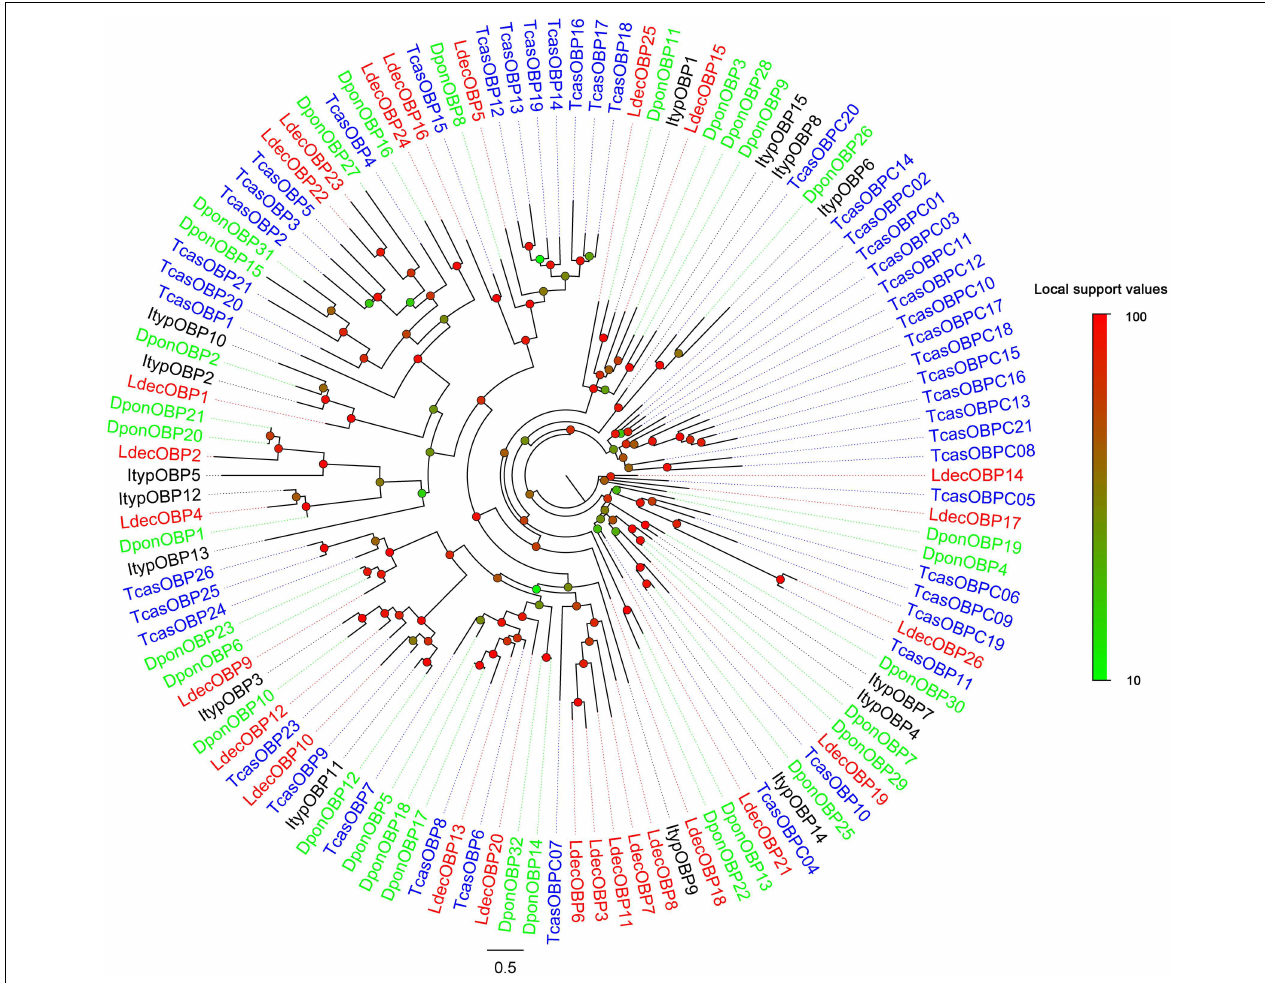
FIGURE 3 | Phylogenetic tree of candidate LdecOBPs with known Coleopteran OBP sequences. Tcas, T. castaneum ; Dpon, D. ponderosae ; Ityp, I. typographus .